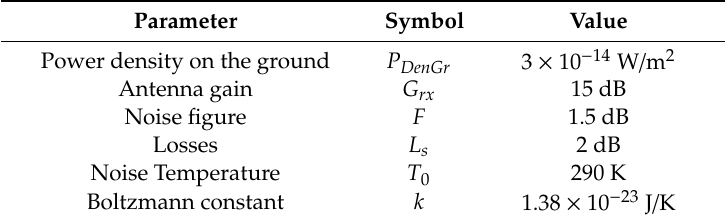
Figure 3. Maximum radar range for P d ≥ 0.9 versus ( a ) target radar cross section (RCS) in the single frame case with P fa = 10 − 4 ; ( b ) number of integrated frames in the multi frame case with P fa = 10 − 4 and P fa = 10 − 2 (RCS = 27 dBm 2 ). Table 1. Receiving chain parameters.